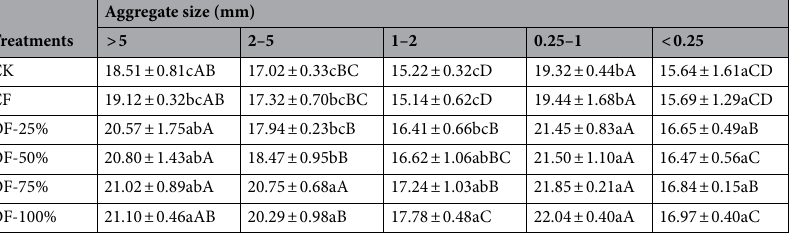
Table 6. Percentage of TOC represented by POC in different fertilization treatments in a gravel-mulched field. Lower-case letters in the same column indicate significant differences in fertilization. Upper-case letters in the same row indicate significant differences in aggregate size ( p < 0.05). CK, no N fertilizer; CF, N fertilizer without organic fertilizer; OF-25%, OF-50%, OF-75%, and OF-100%, 25%, 50%, 75%, and 100% organic fertilizer.